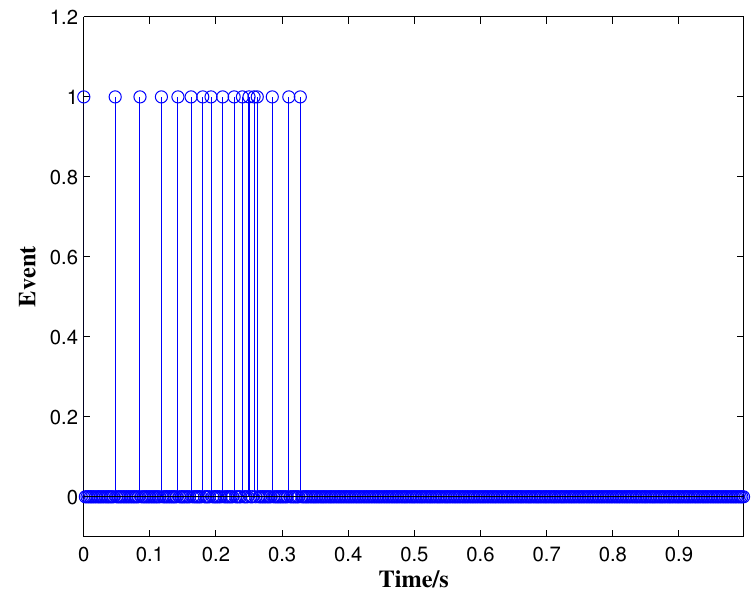
Figure 7. Event-triggered instants under ETC condition (39) with η =